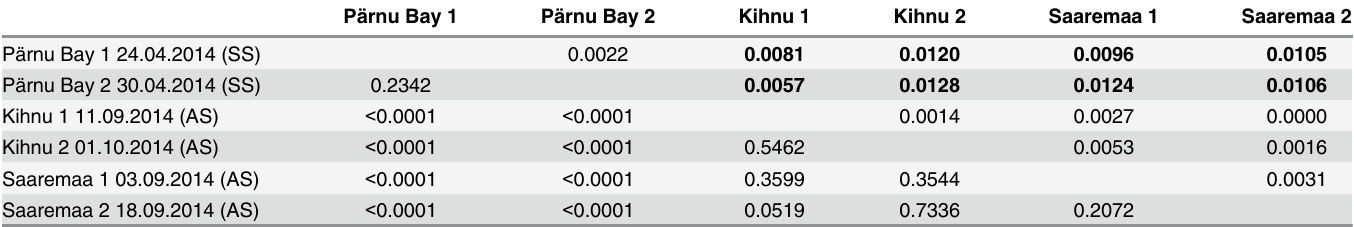
Table 2. Pairwise differentiation ( θ , above diagonal) and P-values for Fisher ’ s tests for differentiation (below diagonal) for SNP and microsatellite markers combined. Statistically significant divergence following FDR correction is shown in bold. SS and AS indicate spawning in respectively spring and